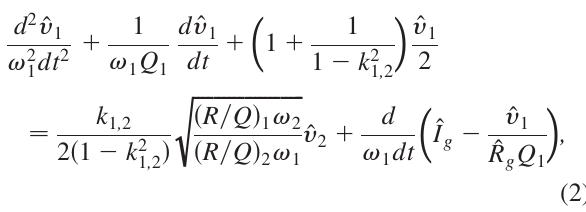
! n n (cid:2) 1 ! n n þ 1